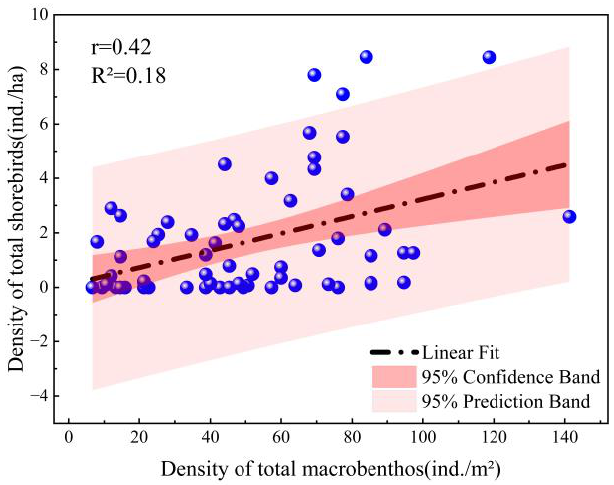
Figure 6. Correlation between density of total macrobenthos and total shorebirds (r = 0.42, p < 0.01). Table 6. The correlation coefficients (r) of shorebird guilds with four taxa and two life-forms of macrobenthos.